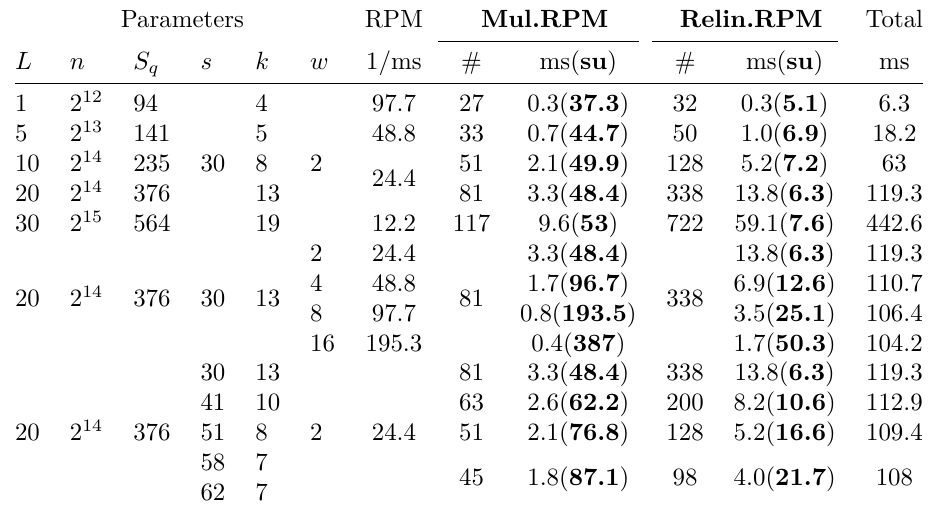
Table 4: Estimated performance of our RPM design over the different parameter sets. Throughput T = n/w . Timings are estimated with a RPM design clocked at 200MHz. Total corresponds to the new timing for ciphertext Mult&Relin. ( su stands for speedup).